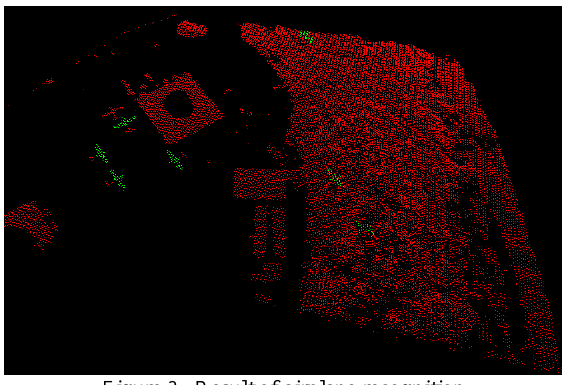
Figure 3. Result of airplane recognition